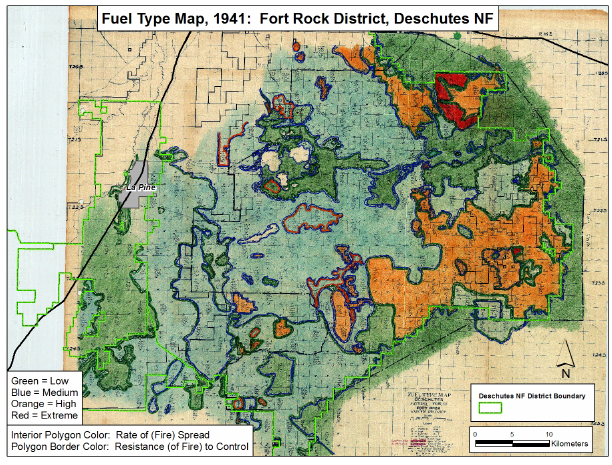
Fig. 4. Example representation of U.S. Forest